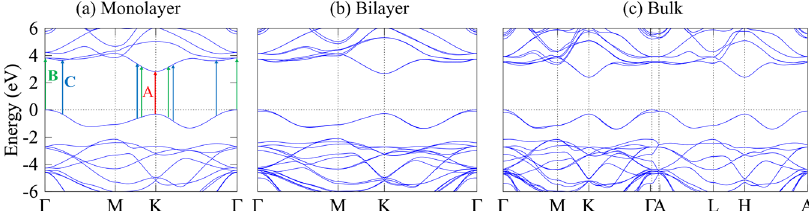
Fig. 4 GW band structures for MoSi 2 N 4 from monolayer to bulk. a – c represent the GW band structure of monolayer, bilayer, and bulk MoSi 2 N 4 , respectively. Important electron and hole states involved in the optical transitions that give rise to the A (red), B (green), and C (blue) low energy absorption peaks in monolayer MoSi 2 N 4 are also shown.